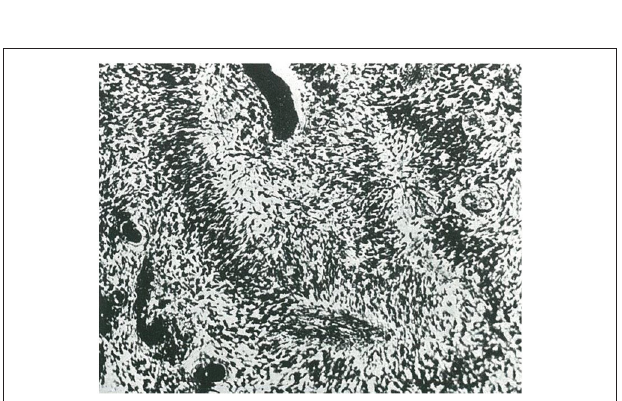
FIGURE 3 | Another example of isomorphic glioblastoma with wave-like arrangement of glioblasts (taken from Río-Hortega, 1933a).